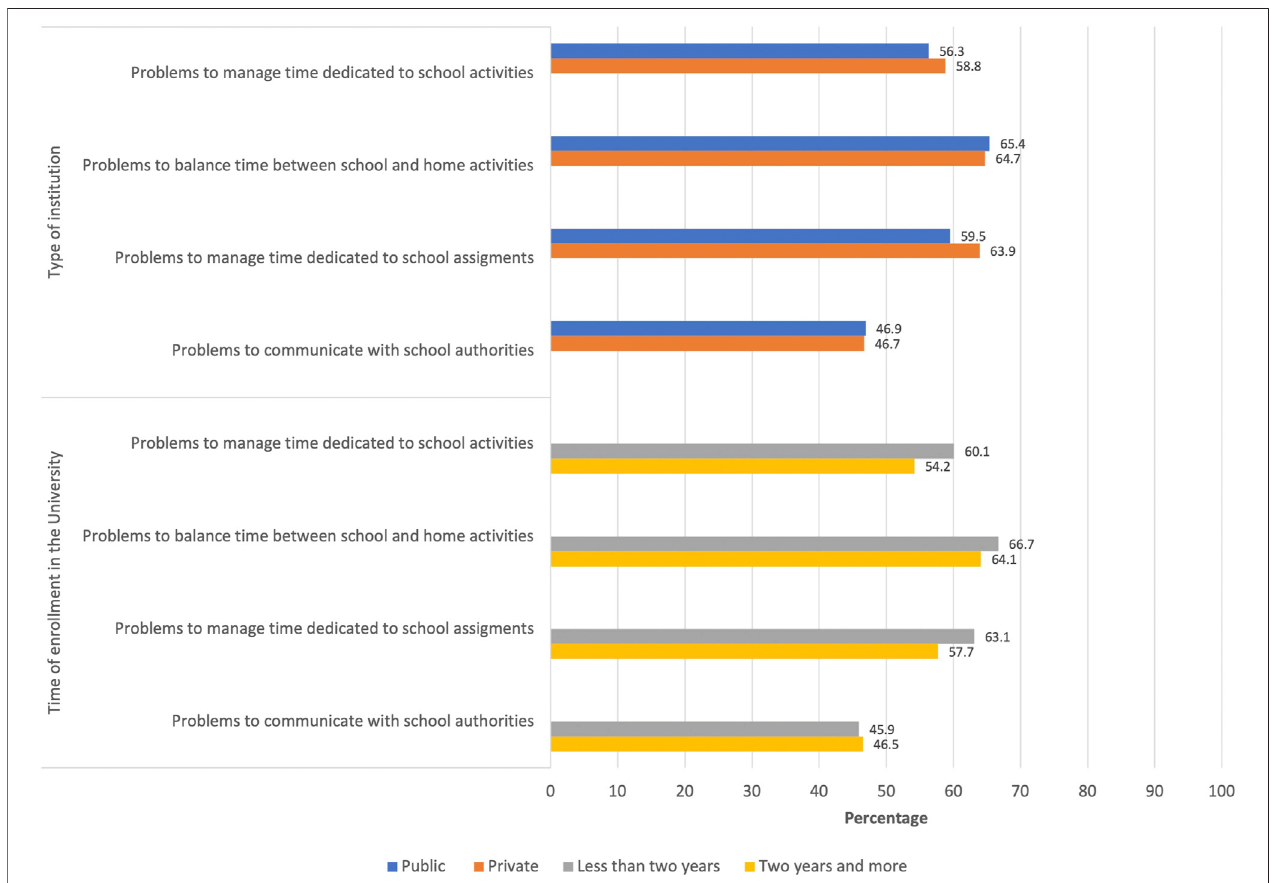
FIGURE 5 | Problems related to school activities before the emergency remote teaching model implementation, by type of institution and time of enrollment in the university.